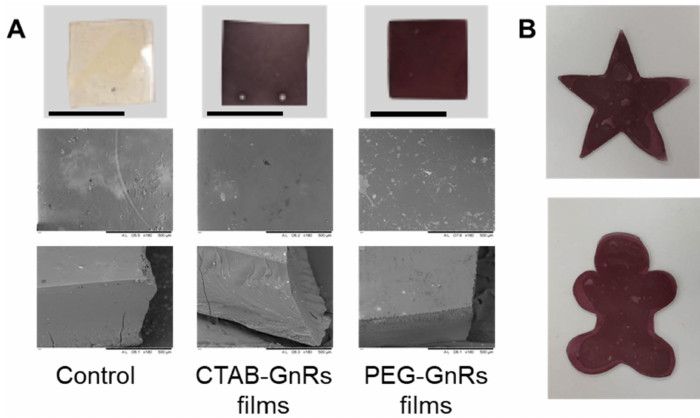
Figure 4. Representative digital and SEM images of polymeric films with GnRs ( A ). Polymeric films cut before crosslinking ( B ) (scale bar on digital images represent 1 cm). Table 2. Physical characterization of films loaded with GnRs (mean ± SD, n =